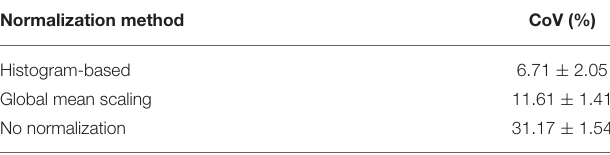
TABLE 1 | Mean CoV values in the brain for the different PET templates.